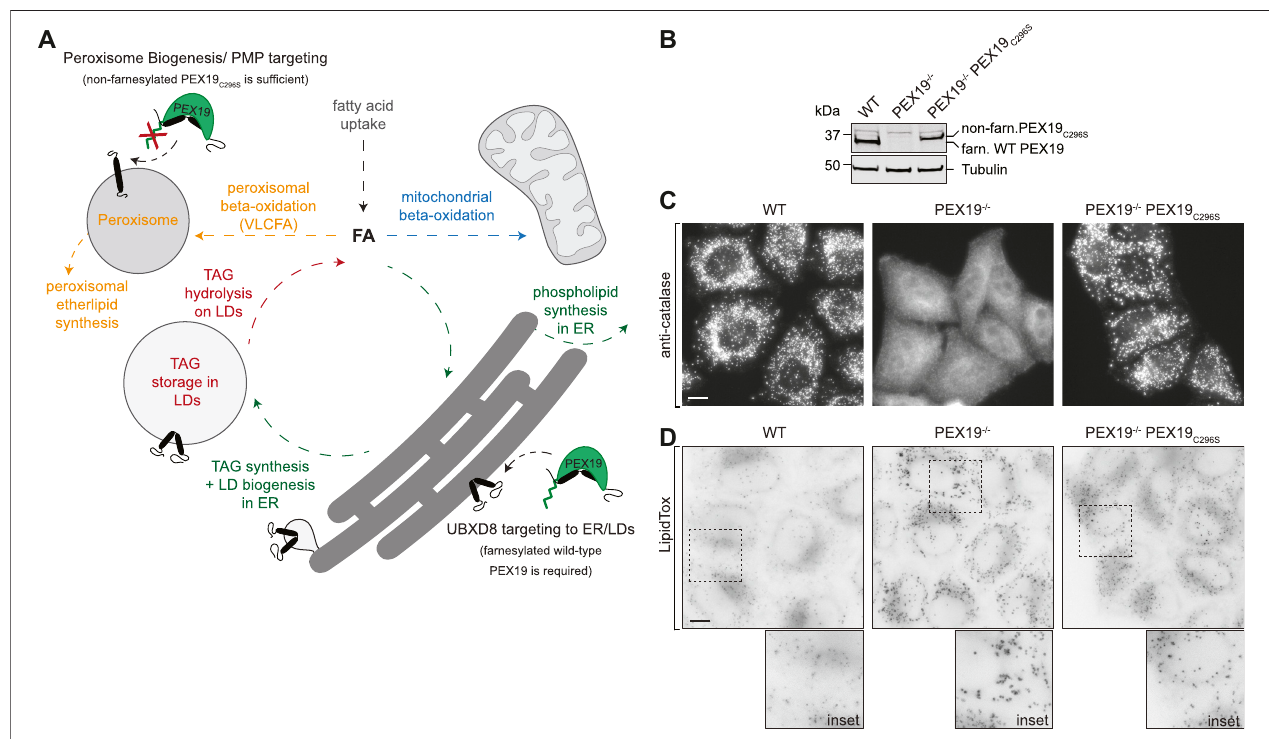
FIGURE 1 | PEX19-compromised cells accumulate excess LDs. (A) Schematic illustrating selected lipid metabolic pathways of peroxisomes, LDs, the ER and mitochondria. The role of PEX19 in peroxisome biogenesis and targeting of peroxisomal membrane proteins (PMPs) to peroxisomes as well as in ER/LD targeting of UBXD8 is indicated. For details see text. FA, fatty acid; TAG, Triacylglycerols, VLCFA, very long chain fatty acids (B) Western blot analysis of cell lysates from WT, PEX19 − / − and PEX19 − / − PEX19 C296S cells as indicated using PEX19-speci fi c antibodies. Farnesylated (farn.) WT PEX19 and non-farnesylated (non-farn.) PEX19 C296S are indicated. Note the farnesylation-dependent shift in the electrophoretic mobility of PEX19, con fi rming that exclusively non-farnesylated PEX19 C296S is expressed in PEX19 − / − PEX19 C296S cells. Western blots using anti-tubulin antibodies serve as loading control. (C) Stable expression of non-farnesylated PEX19 C296S in PEX19 knock-out cells rescues the biogenesis of catalase-positive peroxisomes: Immuno fl uorescence staining of WT, PEX19 − / − and PEX19 − / − PEX19 C296S cells as indicatedusinganti-catalaseantibodies.Maximumintensityprojectionsofz-stacksareshown.Scalebar:10 µm (D) PEX19-compromisedcellsaccumulateexcessLDs: Micrographs showing LipidTox-staining of living WT, PEX19 − / − and PEX19 − / − PEX19 C296S cells as indicated. Inverted, maximum intensity projections of z-stacks are shown. Scale bar: 10